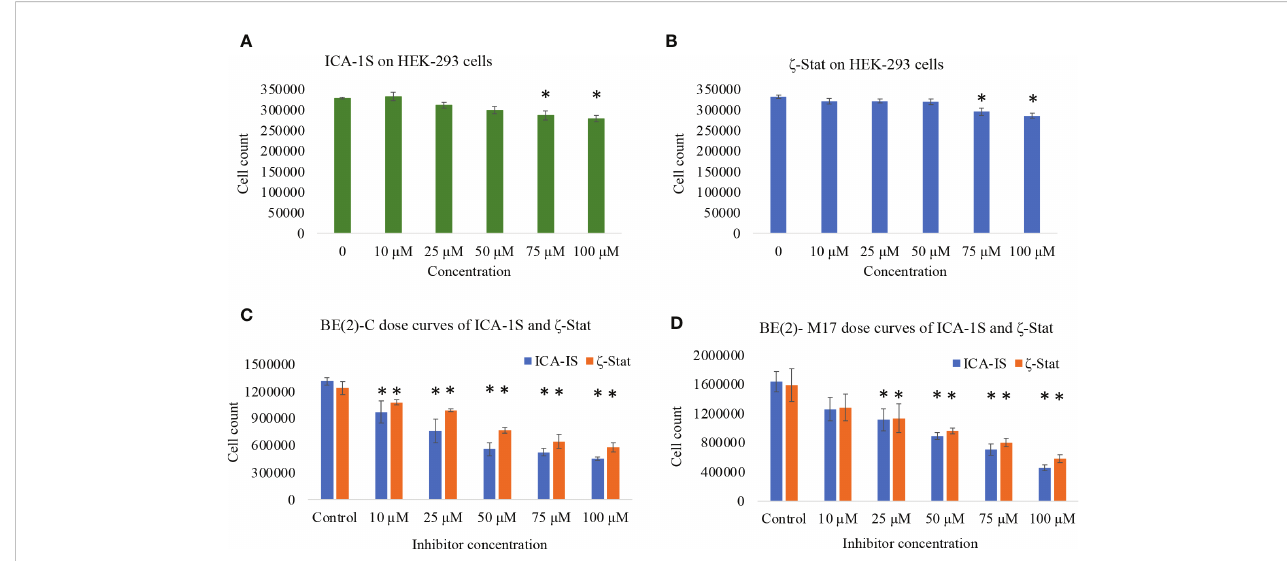
FIGURE 1 The effects of aPKC inhibitors (ICA-1S and z -Stat) on cell proliferation, cell viability and cytotoxicity for HEK-293, BE(2)-C and BE(2)-M17 cells. Dose response curves showing (A) effect of ICA-1S on HEK-293; (B) effect of z -Stat on HEK-293; (C) effect of ICA-1S/ z -Stat on BE(2)-C; and (D) effect of ICA- 1S/ z -Stat on BE(2)-M17. Mean ± SD ( N = 3) are plotted. Statistical signi fi cance is indicated by asterisk as * P <